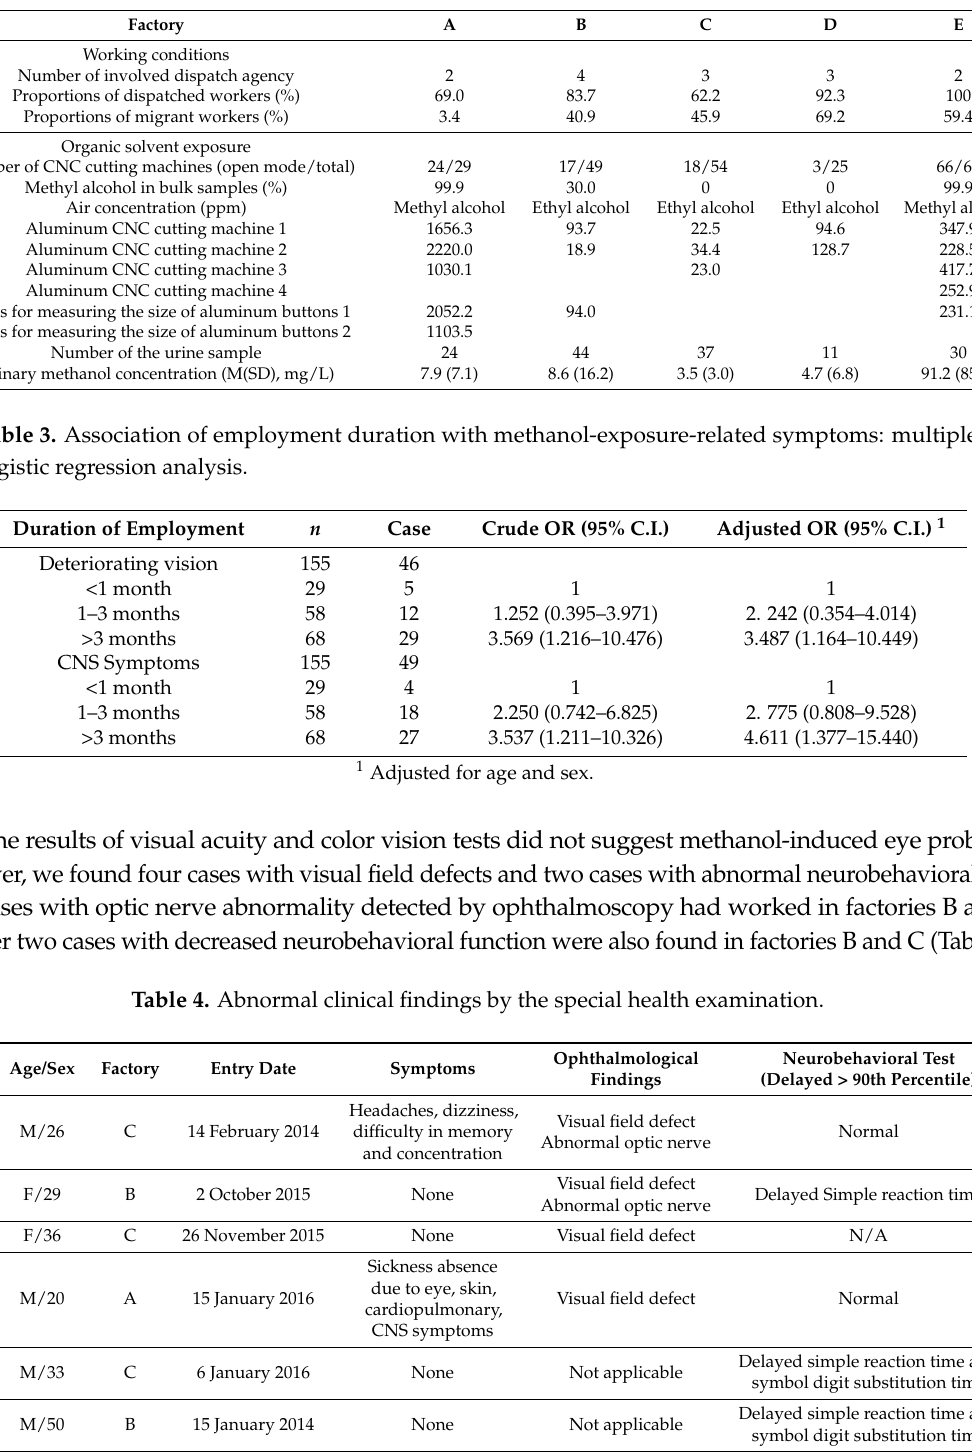
Table 2. Characteristics of the working conditions and the exposure to organic solvents in the five factories.